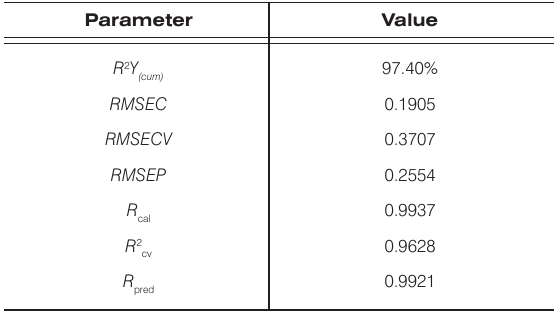
Table 3. Statistical parameters of the obtained PLS